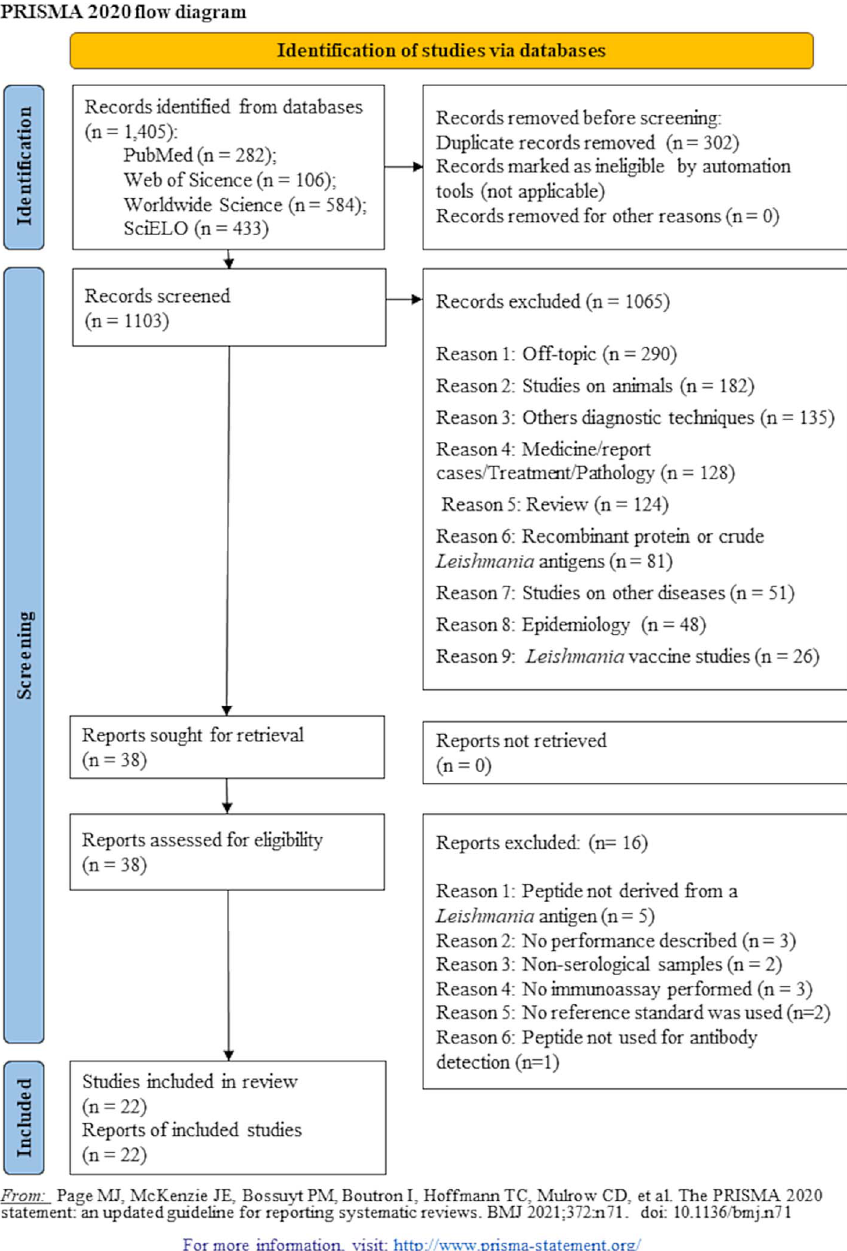
Figure 1. PRISMA Flowchart of the selection steps undertaken in the systematic